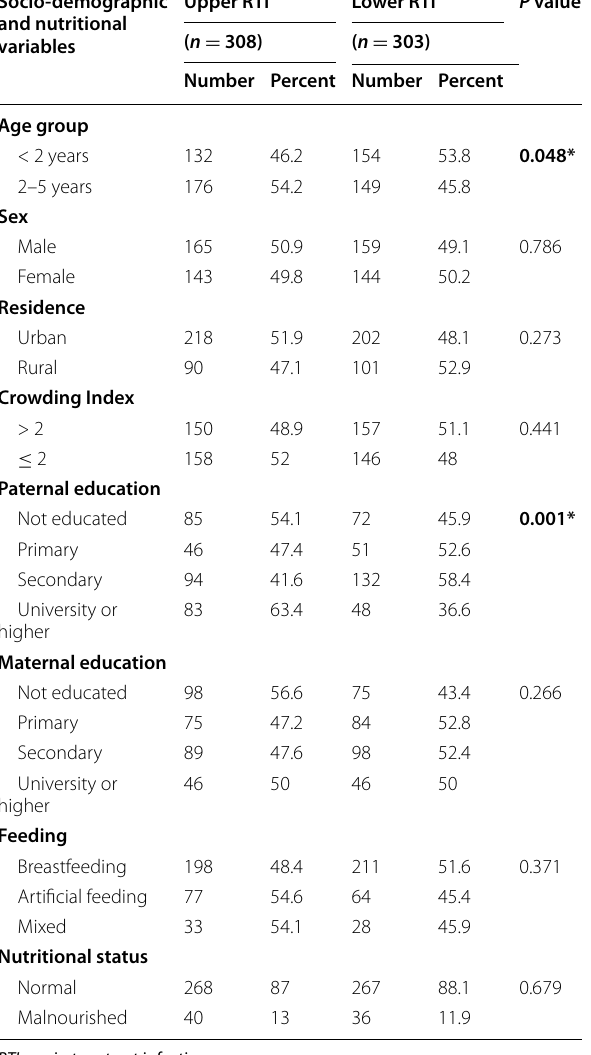
Table 3 Socio‑demographic differences between normal and malnourished children under 5 years of age with upper and lower RTIs (combined) in the study group, Cairo University